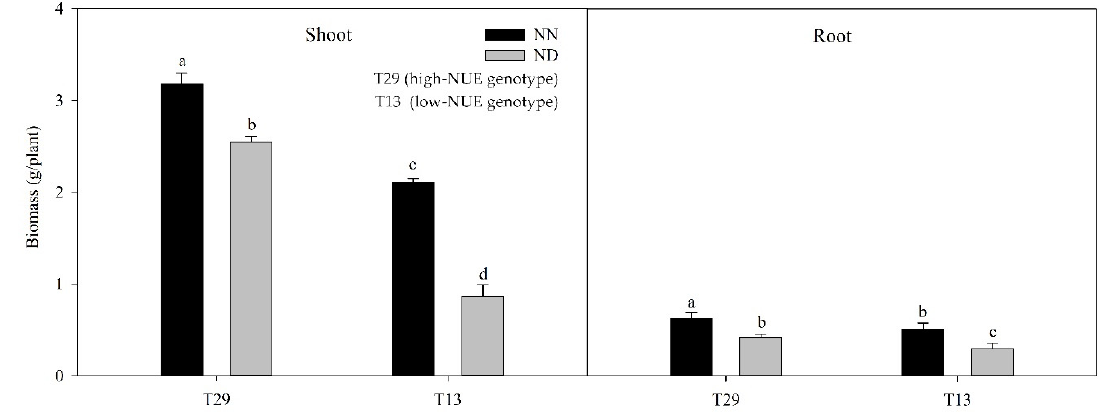
Figure 1. Plant growth performance of ramie genotypes under nitrogen deficiency. ND: N-deficient conditions, NN: normal-N conditions. The error bar represents the standard error. The different letters in the chart indicate significant differences at p < 0.05 between the genotypes according to SNK test. Table 2. Functional annotation of the ramie transcriptome in the seven public databases searched. Database